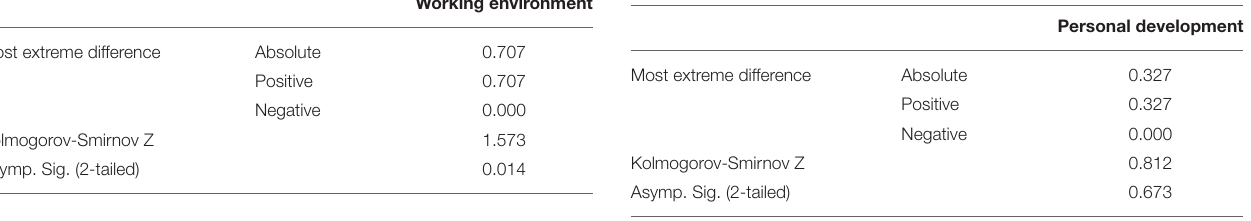
TABLE 10 | Kolmogorov–Smirnov test results of the index “personal development”.